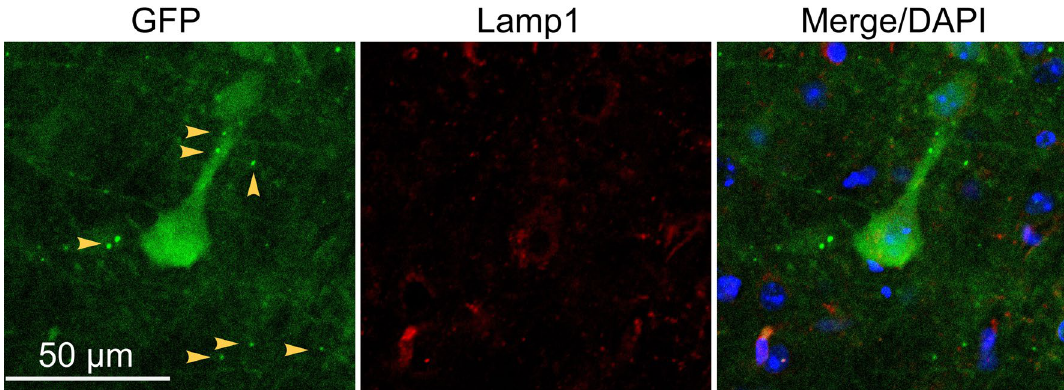
Figure 3. Immunostaning of lamp1 and EGFP to demonstrate the localization of endocytotic vesicles and EGFP particles in the cortex. Yellow arrows, EGFP particles do not co-localize with